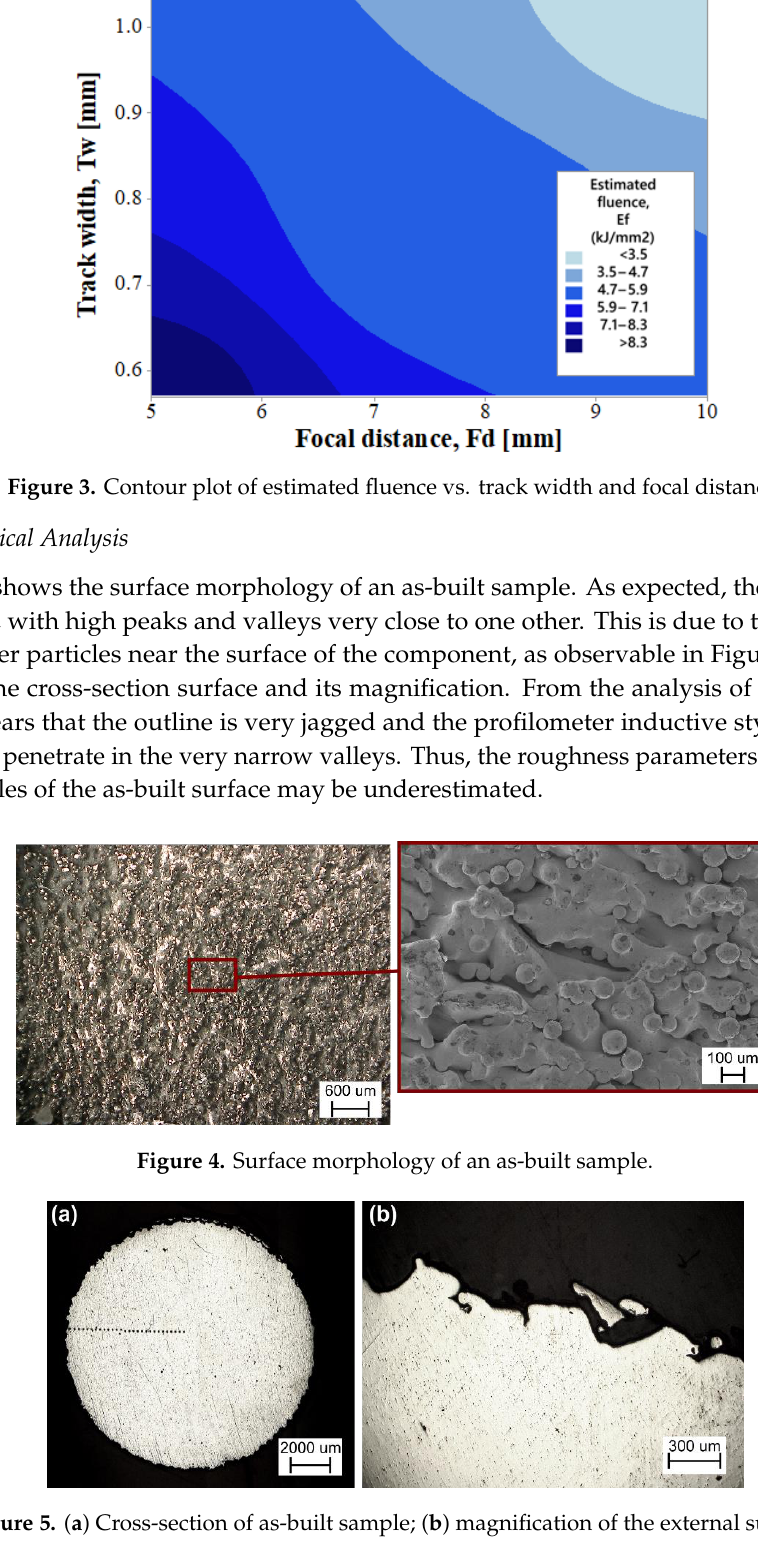
Focal Distance, Fd (mm)